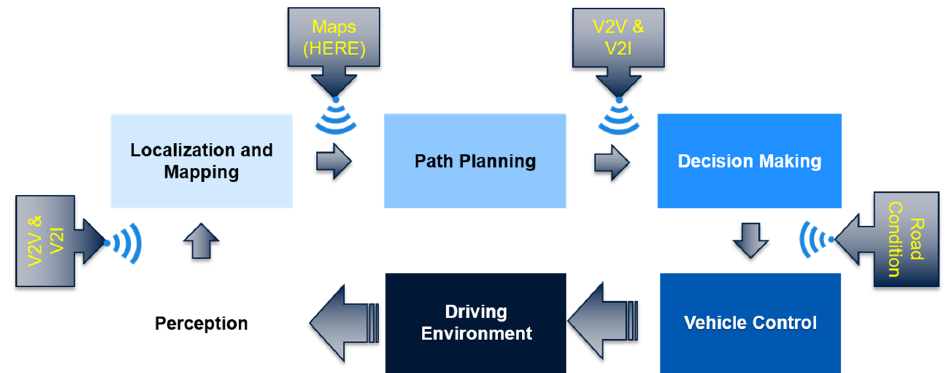
Figure 2. Full autonomous navigation system. Sensor technology and sensor fusion overview. V2V, vehicle-to-vehicle; V2I, vehicle-to-infrastructure.